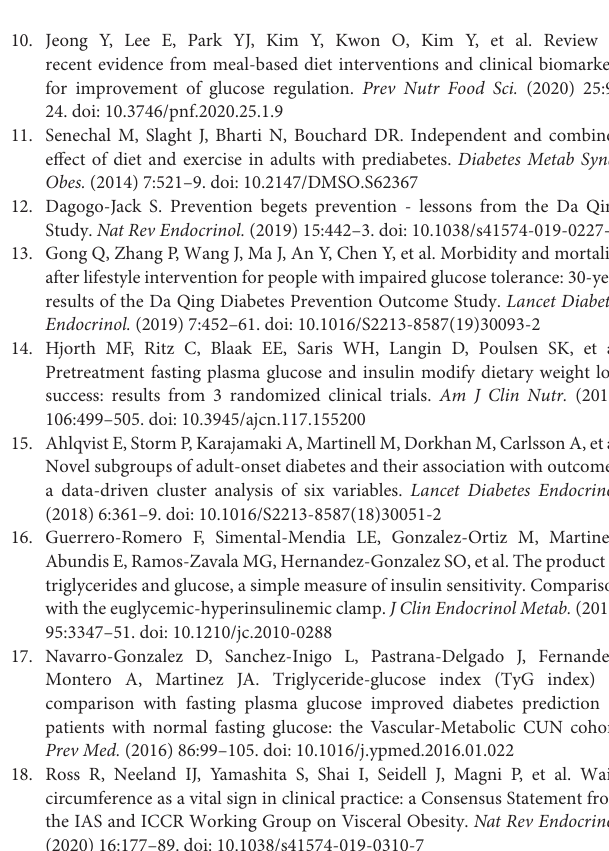
Supplementary Table 1 | CONSORT Statement checklist, as required by the ICMJE. Supplementary Figure 1 | Flowchart of the volunteers involved in the study, and whose data were analysed in the present article (Screened, Eligible and Completers, as well as those with valid full